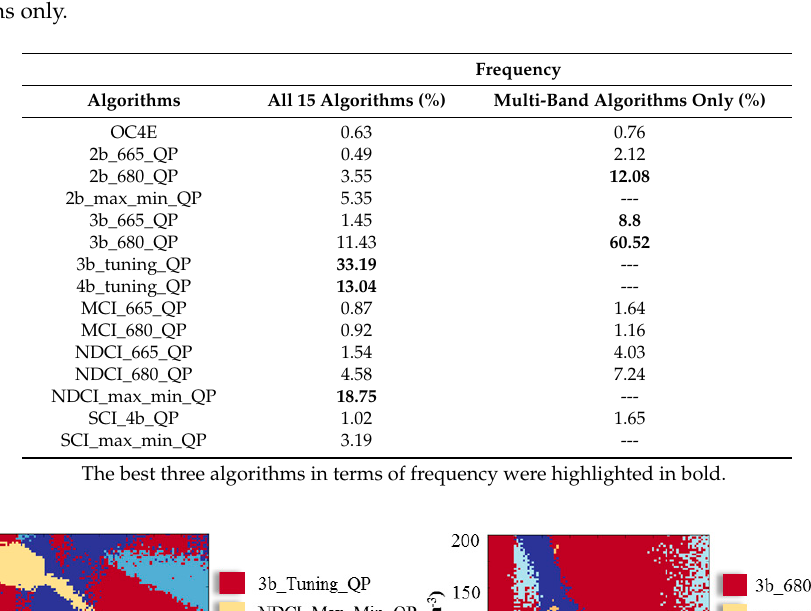
Table 5. Frequency of each algorithm to achieve the minimum RMSE of the 10,000 combinations of Chla and NAP concentrations. The evaluation executed among OC4E and quadratic polynomial algorithms only.